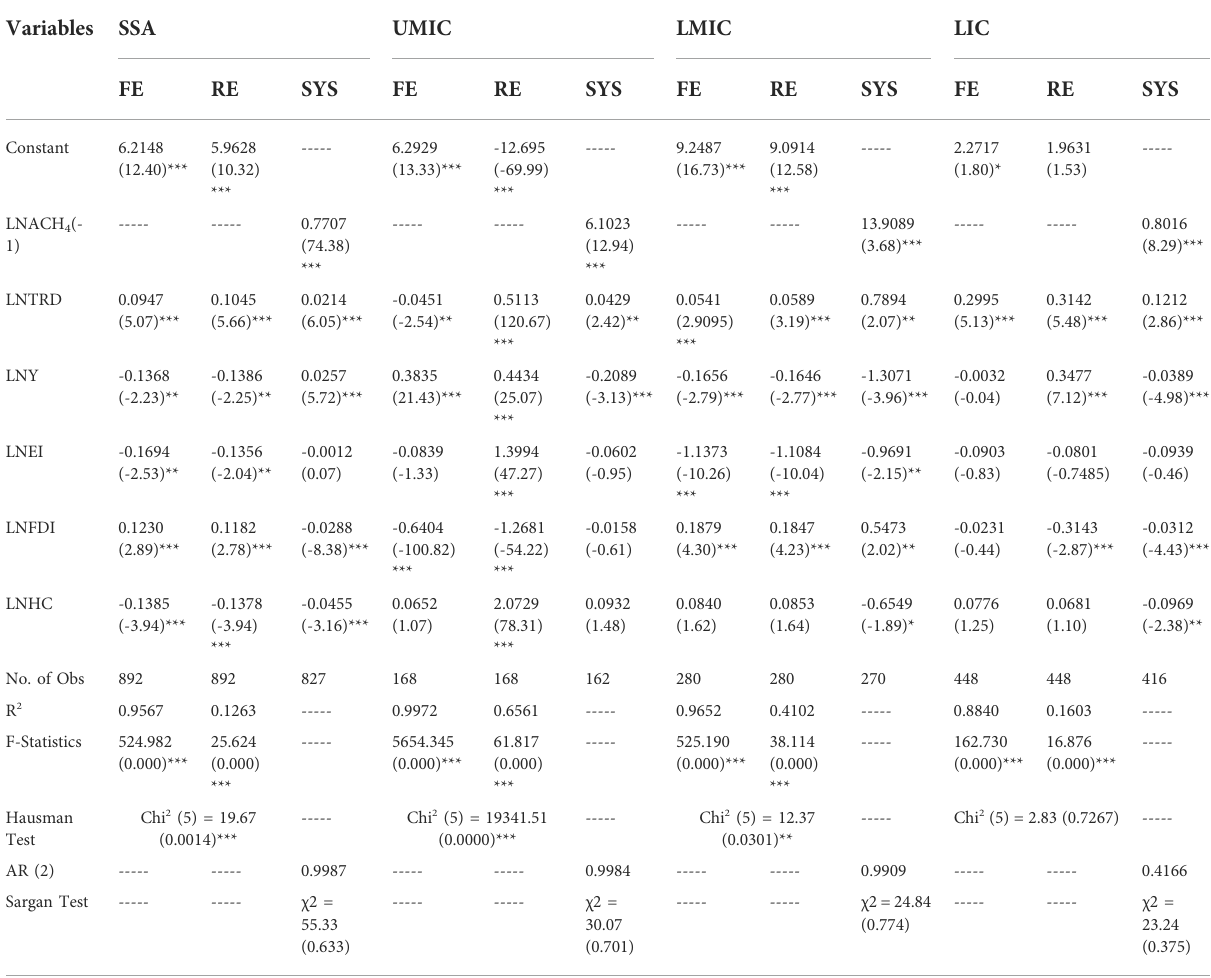
TABLE 2 Panel estimation results: LNACH 4 as the dependent